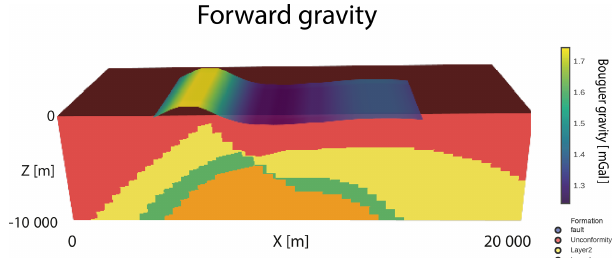
Figure 6. Forward gravity response overlayed on top of a 3-D lithol- ogy block sliced on the Y